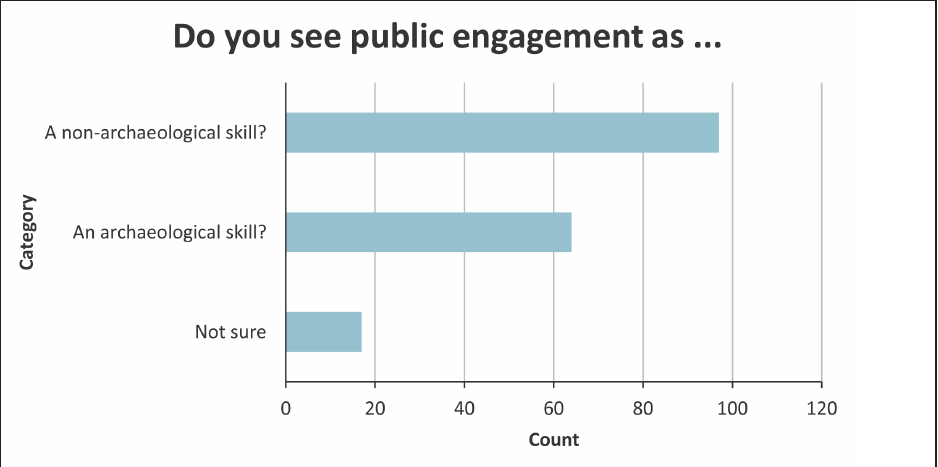
Fig. 3: Is public engagement considered an archaeological skill? The IfA report Profiling the Profession (Aitchison and Edwards, 2008) listed public outreach as a non-archaeological skill despite a reported rise in the number of designated posts in education and outreach ( ibid .: 116, 135). Source of data: National Survey on Public Engagement in Commercial Archaeology May-June 2013, n=181 (© Hilary